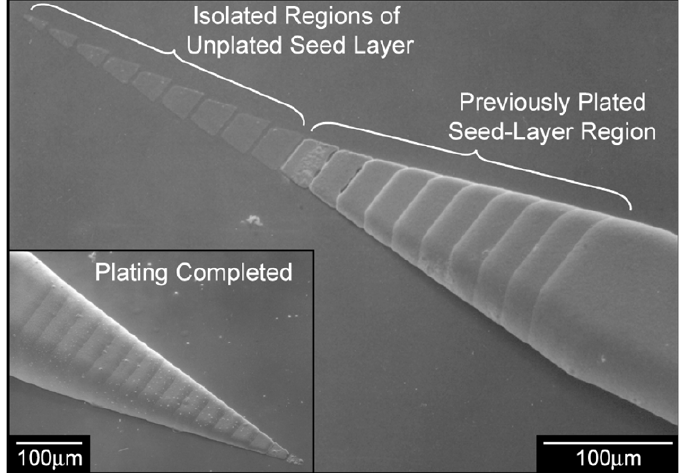
Figure 5. Electrodeposition of the mechanical layer in the probe shank. The SEM image shows the seed-layer regions that are not plated and those previously plated. The inset image on the low left shows the finished tip of the electroplated microprobe. Reprinted from [68]; ©